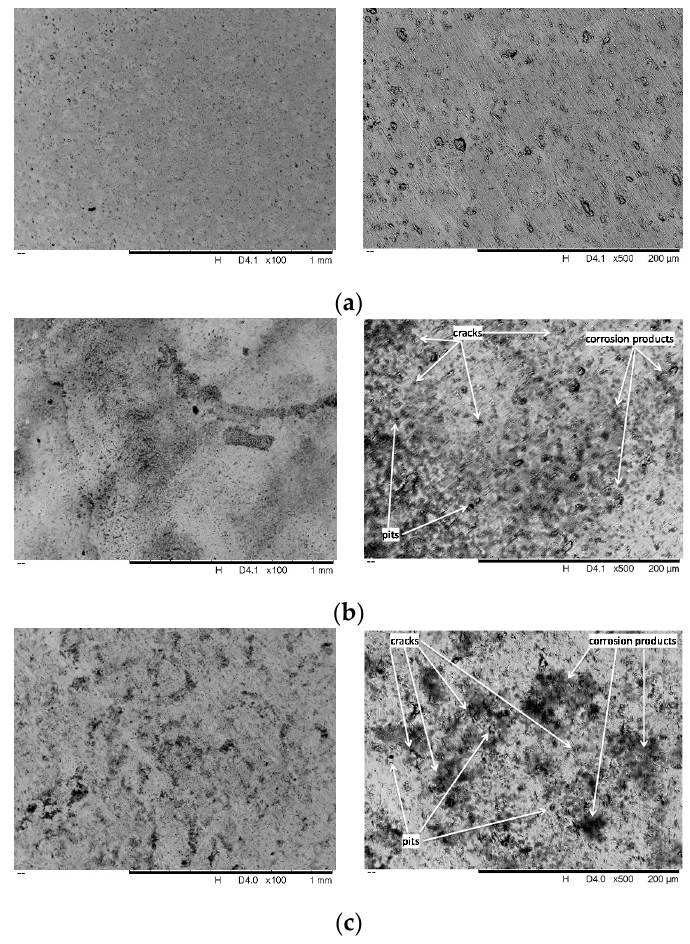
Figure 3. Scanning Electron Microscopy (SEM) images of the alloy surface before and after electrochemical tests. ( a ) Before corrosion; ( b ) after corrosion in SBF; ( c ) after corrosion in